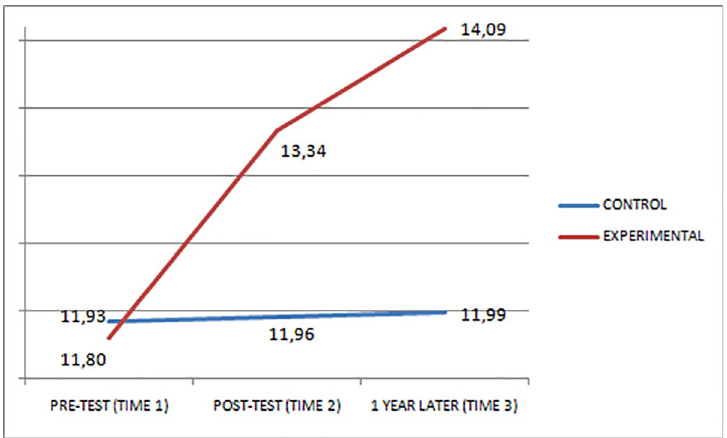
Fig 3. STEM performance of the groups at pre-test (Time 1), post-test (Time 2), and one year after (Time 3).